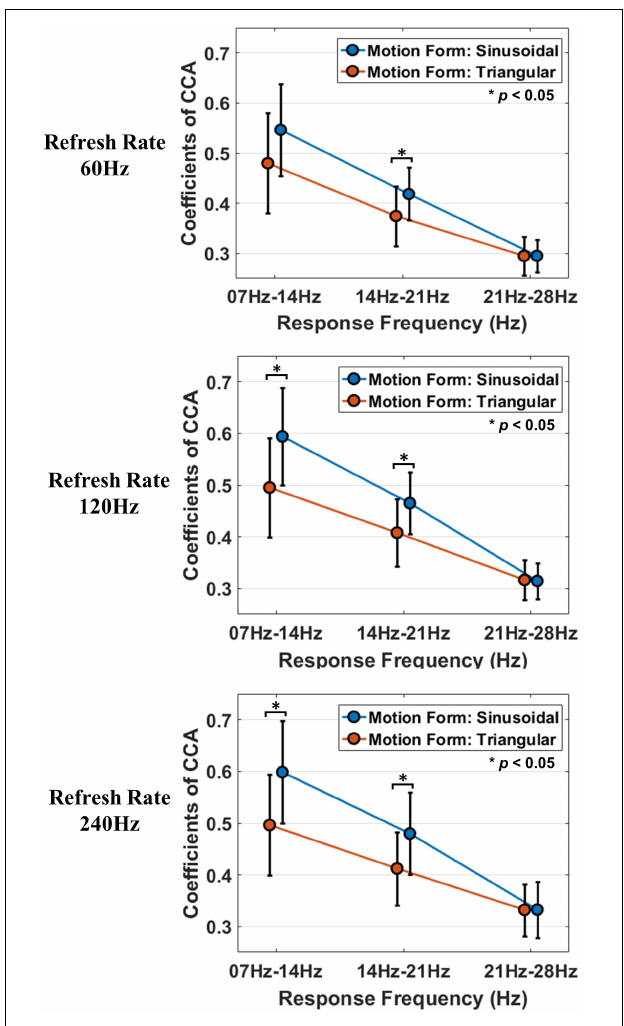
FIGURE 8 | The simple effect analysis results of motion forms in each refresh rate group. Different colors are used to indicate different motion forms, and the asterisks indicate that the difference is statistically significant at the level of α = 0.05. The vertical axis indicates the coefficients of CCA, and the horizontal axis indicates the stimulation frequency.